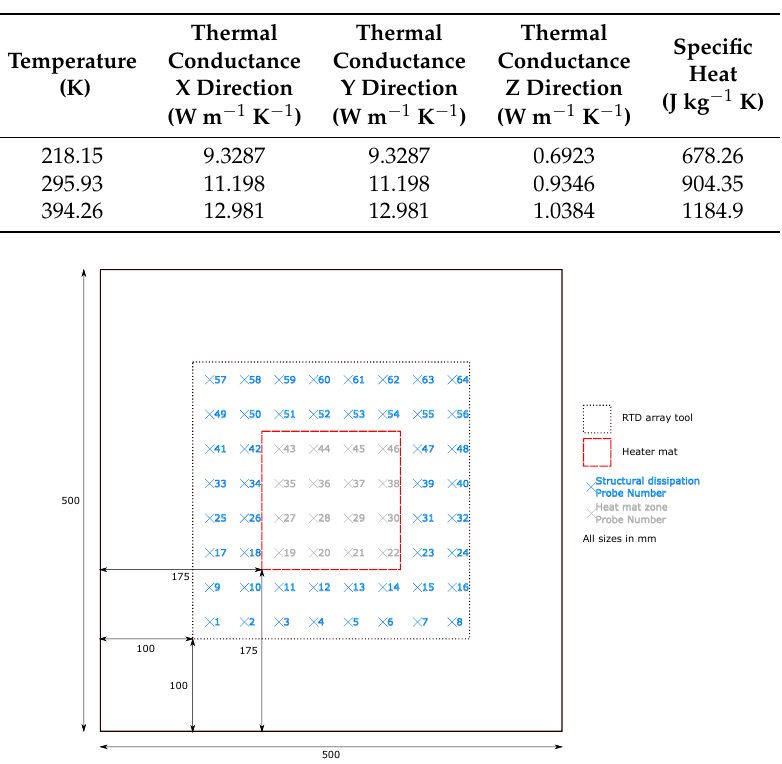
Table 1. Material thermal properties for biaxial laminate composite plies.